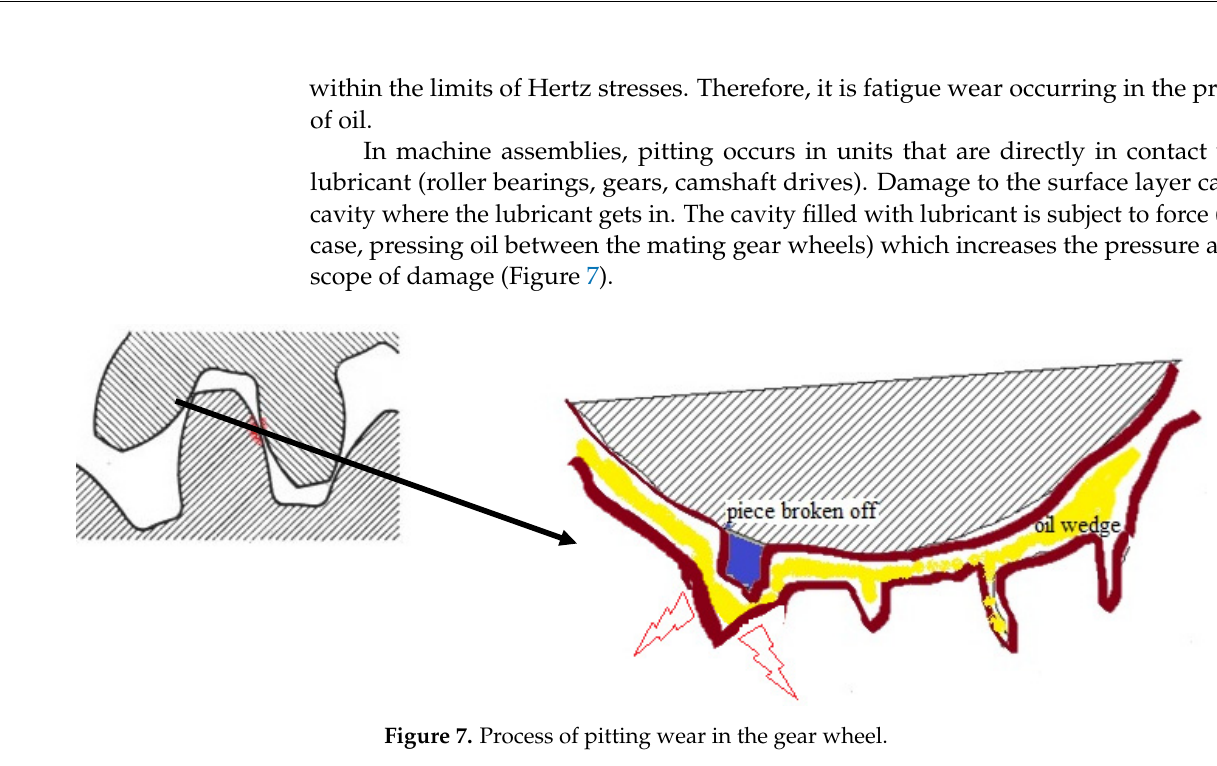
Figure 6. The effect of planetary gear teeth wear in wind turbines in the form of spots caused by gases released inside the nacelle.